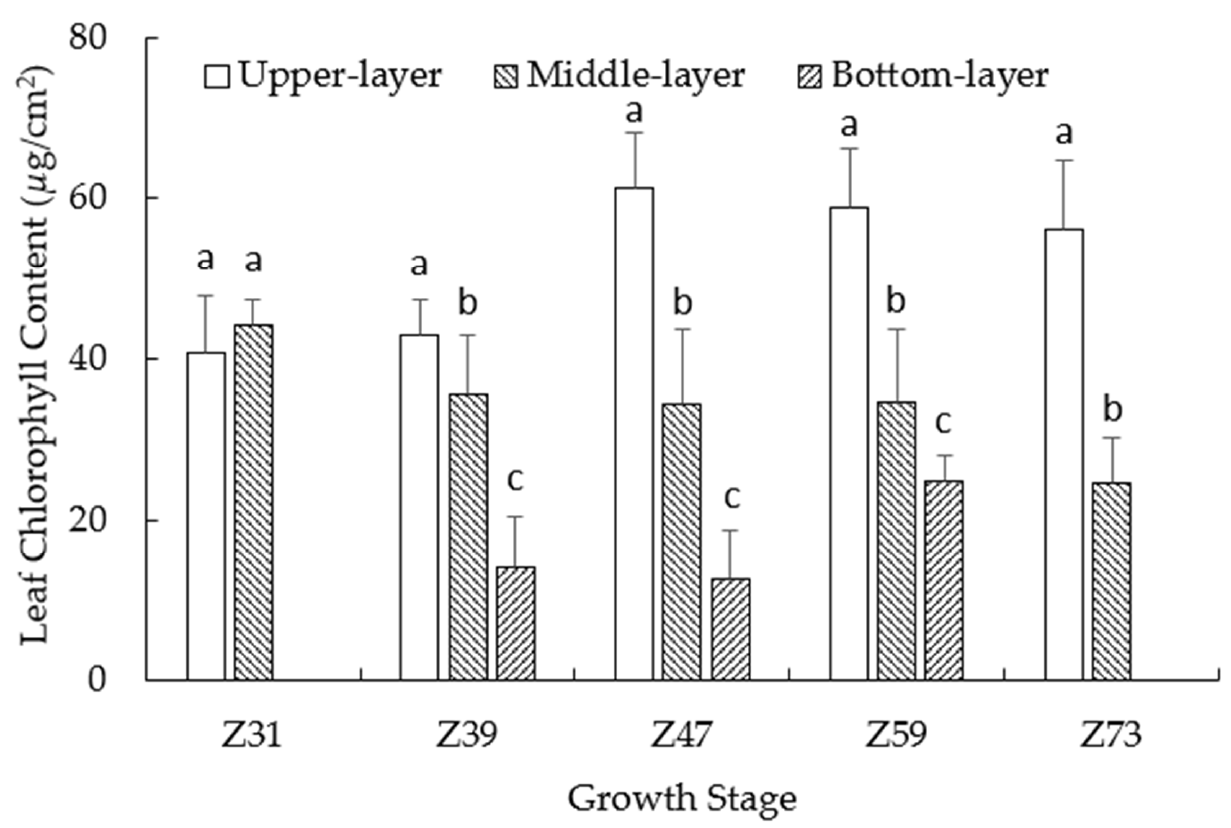
Figure 2. The leaf chlorophyll content in different vertical layers of Wheat. For Z39, Z47, and Z59, bars with different letters indicate significant differences among the canopy layers based on ANOVA and LSD test ( p < 0.05). For Z31 and Z73, bars with different letters indicate significant differences based on pairwise comparisons and Mann–Whitney U test ( p < 0.05).